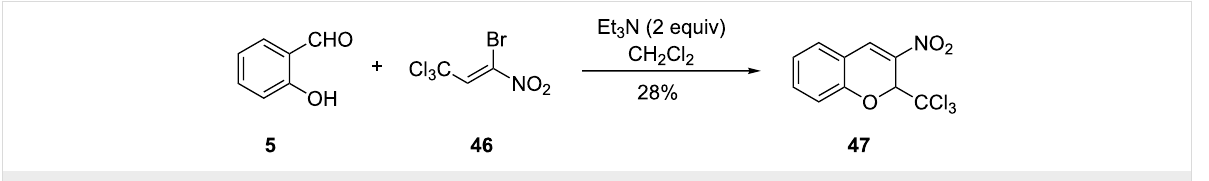
Scheme 18: Synthesis of 2,3-disubstituted chromene 47 by Stukan and